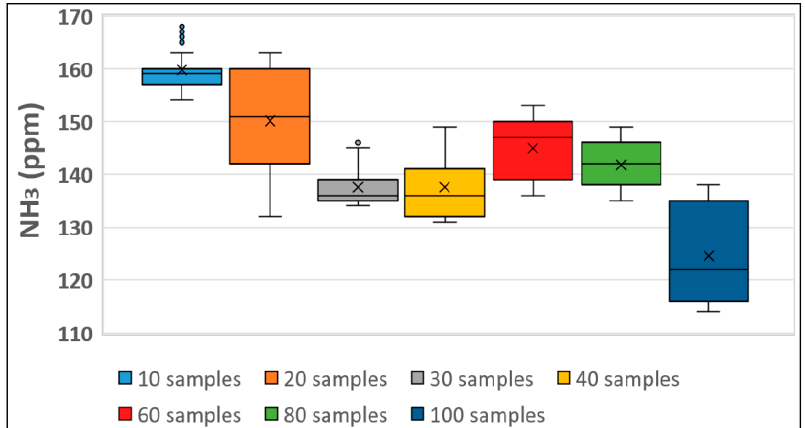
Figure 3. Oscillation range of TGS-826 detection which detects ammonia and amines.